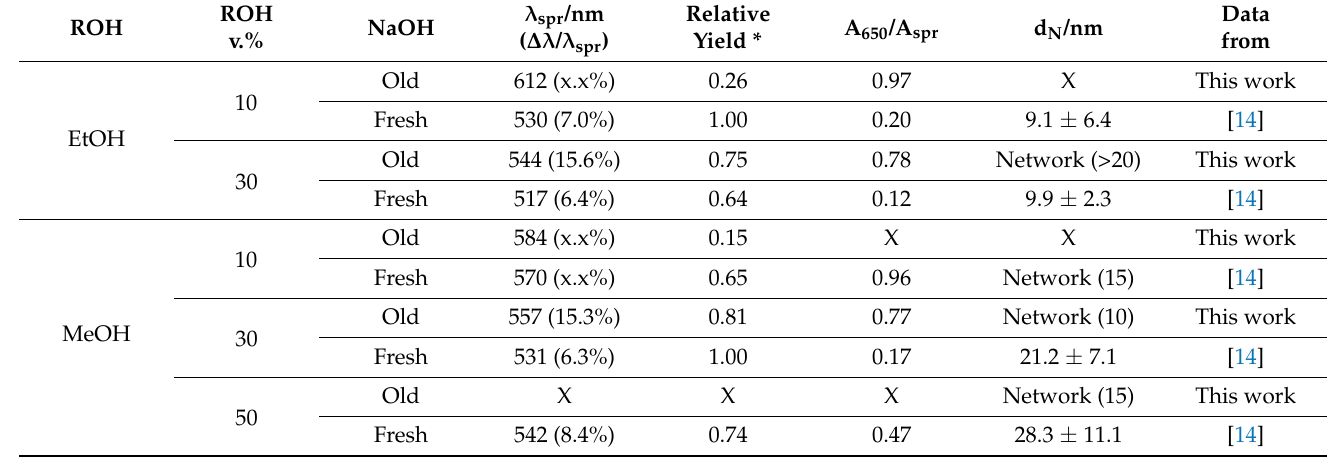
Table 1. Effect of using a fresh or and old stock solution of NaOH for the synthesis of RT surfactant- free Au NPs, for different ROHs and different v.% of ROH. UV-vis and TEM characterization for syntheses performed with 2 mM NaOH and 0.5 mM HAuCl 4 (NaOH/Au molar ratio of 4) for a total volume of 13 mL and 24 h at RT. A more complete table is provided in Table